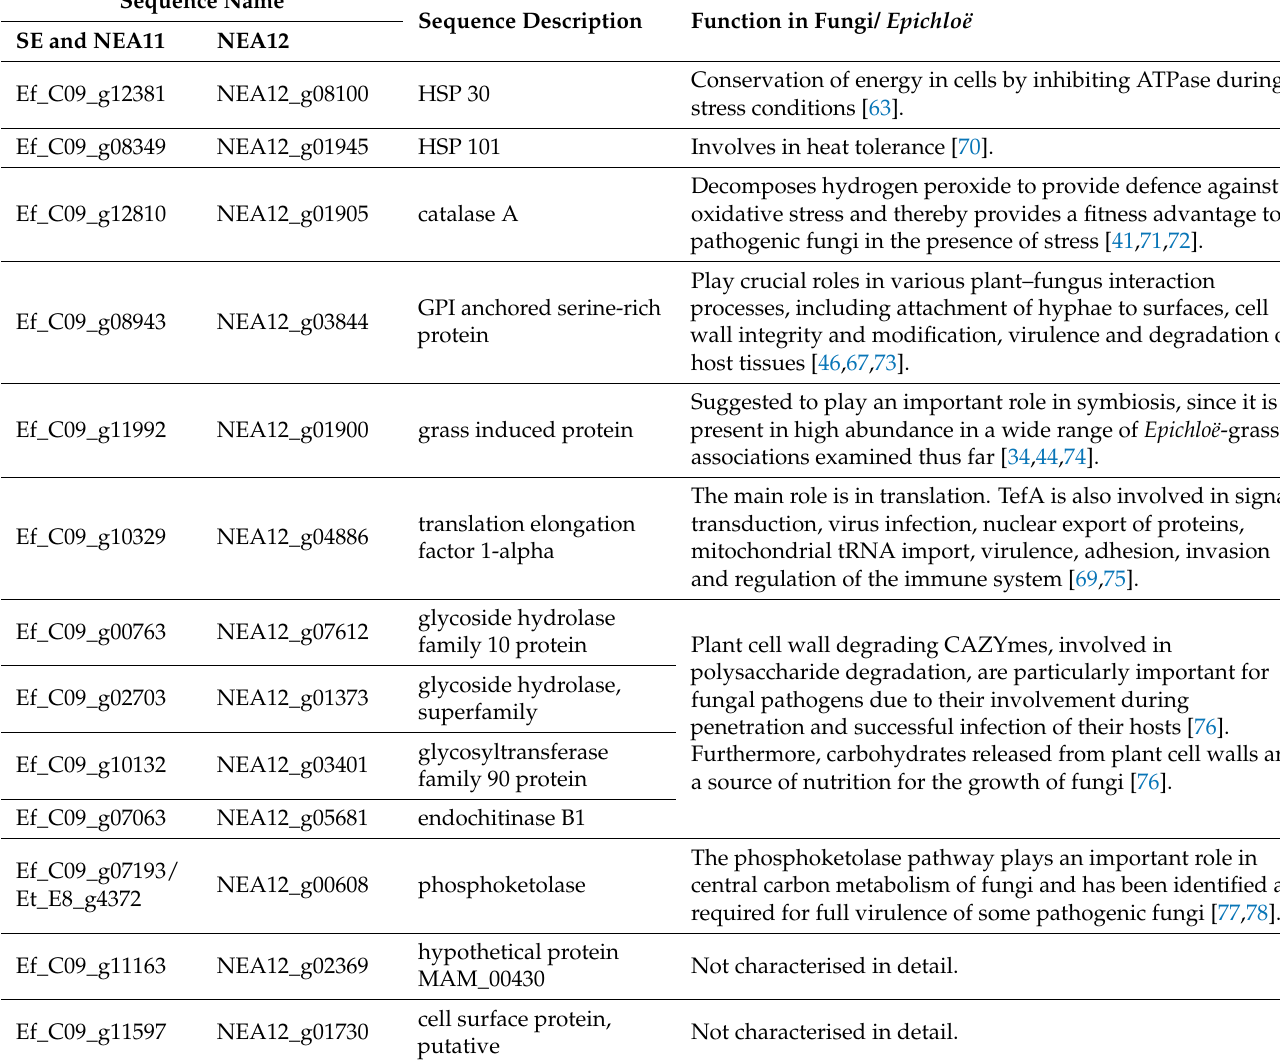
Table 2. The most abundant genes common to SE, NEA11, and